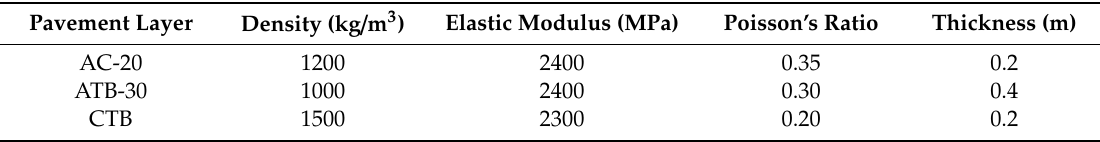
Figure 4. The thickness and material of the backfill in numerical analysis.